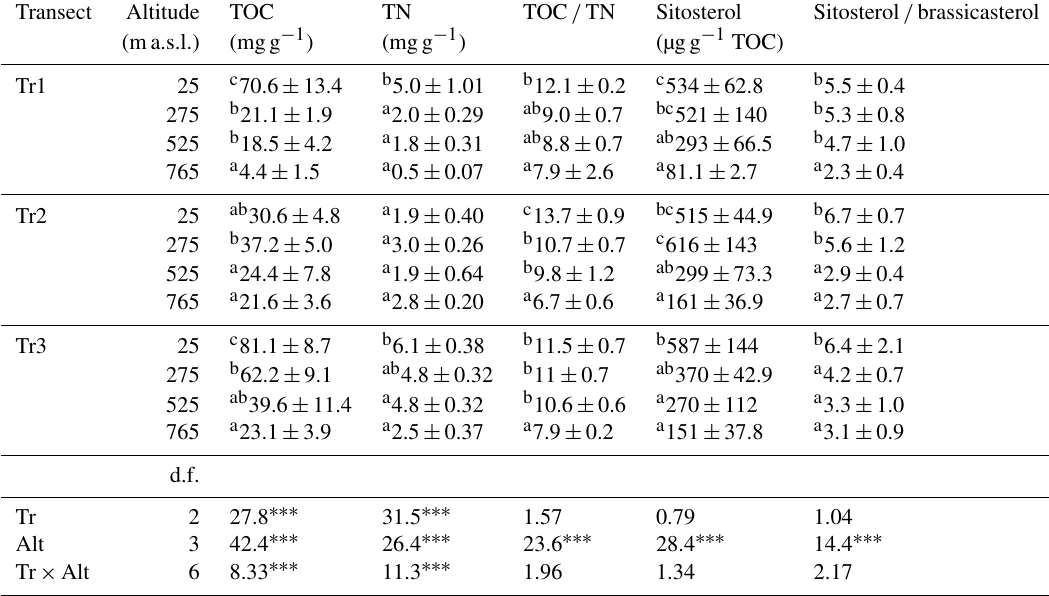
Table 3. Total soil carbon (TOC) and nitrogen (TN) contents, their molar ratios, contents of sitosterol in TOC, and sitosterol / brassicasterol ratios in soils along three altitudinal transects (Tr1–Tr3). Means ± SD ( n = 3) are given in the upper part of the table. Results of two-way ANOVA ( F values) of the effects of transect (Tr), altitude (Alt) and their interaction (Tr × Alt) are presented in the lower part of the table. Transect Altitude TOC TN TOC / TN Sitosterol Sitosterol / brassicasterol